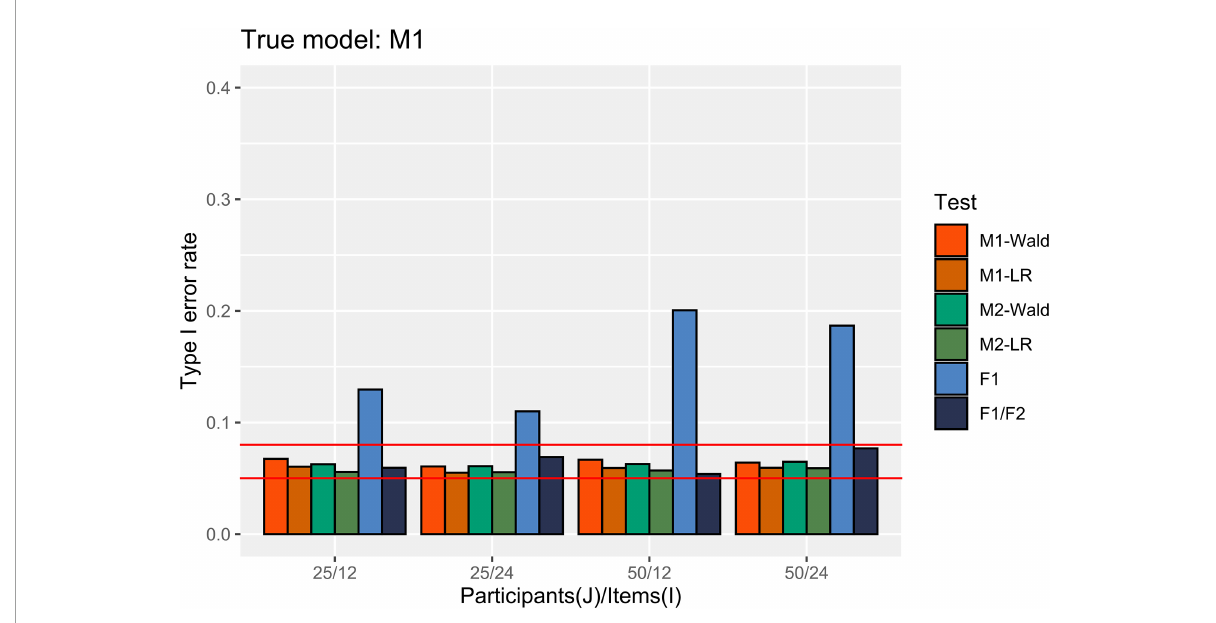
FIGURE3 Power in the conditions where [ ω 2 1 , ω 2 2 ] = [0.2, 0.2]. The auxiliary line indicates 0.80.